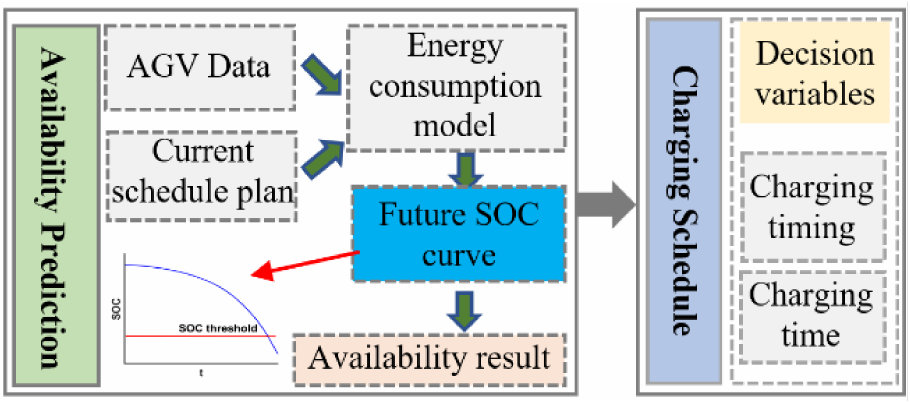
Figure 5. AGV Availability